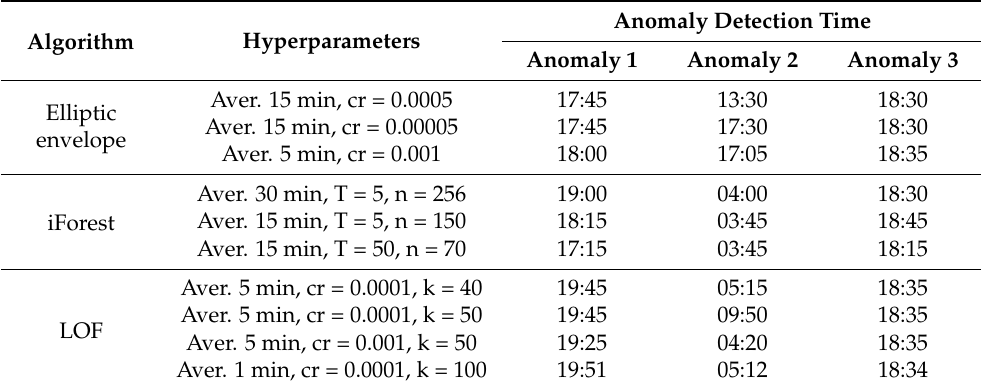
Table 1. Comparison of algorithms by anomaly detection